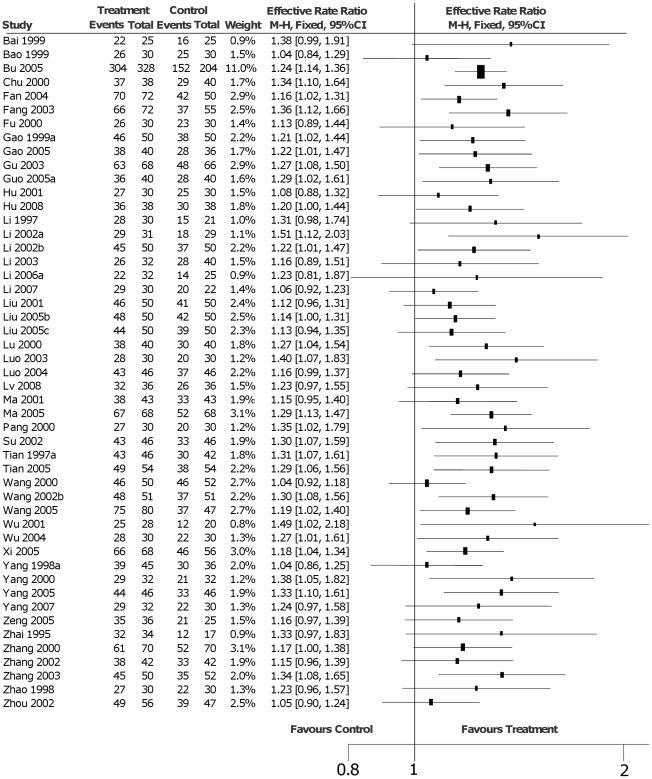
Effective rate analysis based on improvements of classification in NYHA.